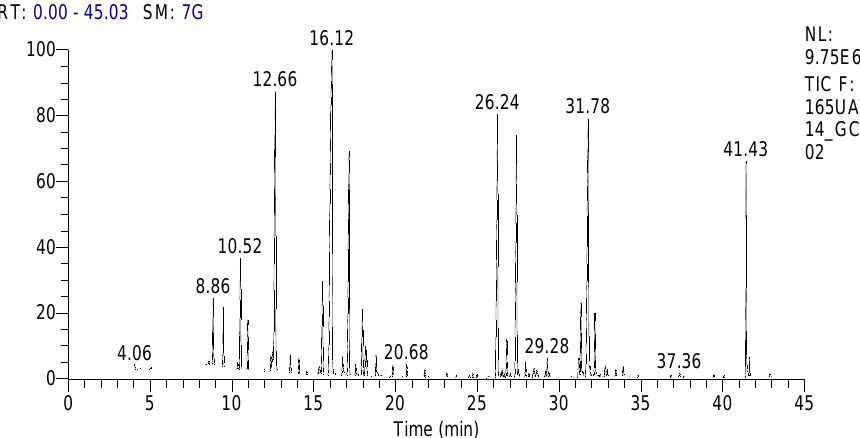
Figure 2. GC chromatography of SOEO at the beginning of the flowering stage.